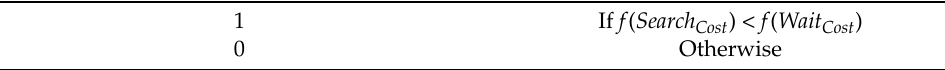
Table 1. Representation of